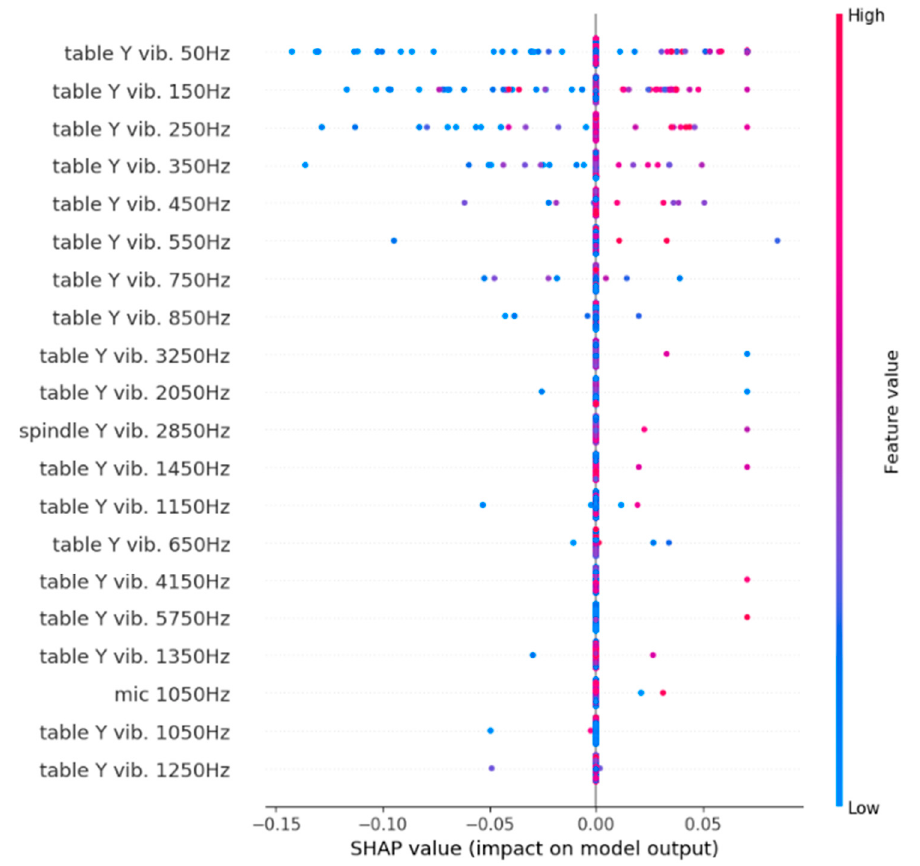
Figure 5. Feature importance scatter plot.